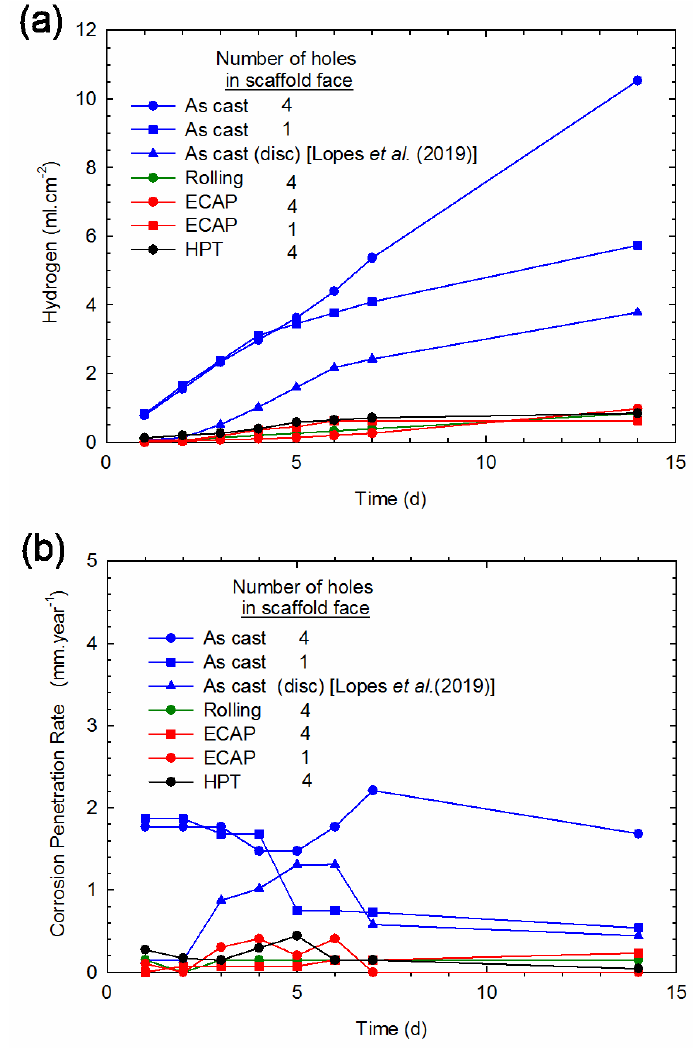
Figure 5. ( a ) Volume of hydrogen produced during immersion and ( b ) corrosion penetration rate of different samples plotted as a function of the immersion time.